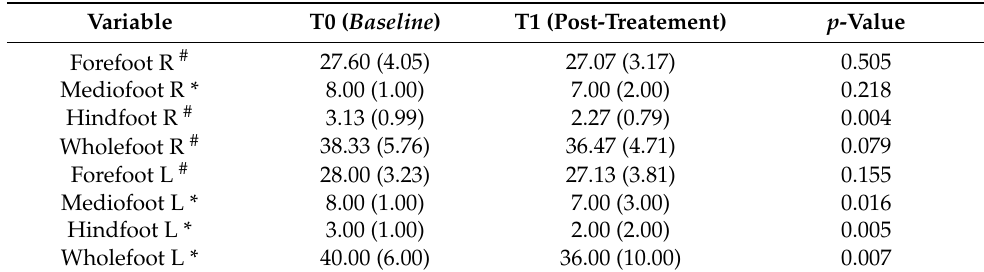
Table 2. Intragroup comparisons (T0 vs. T1) of plantar tactile sensitivity for the control group of older women participating in the study. Jequi é , Bahia, 2022.